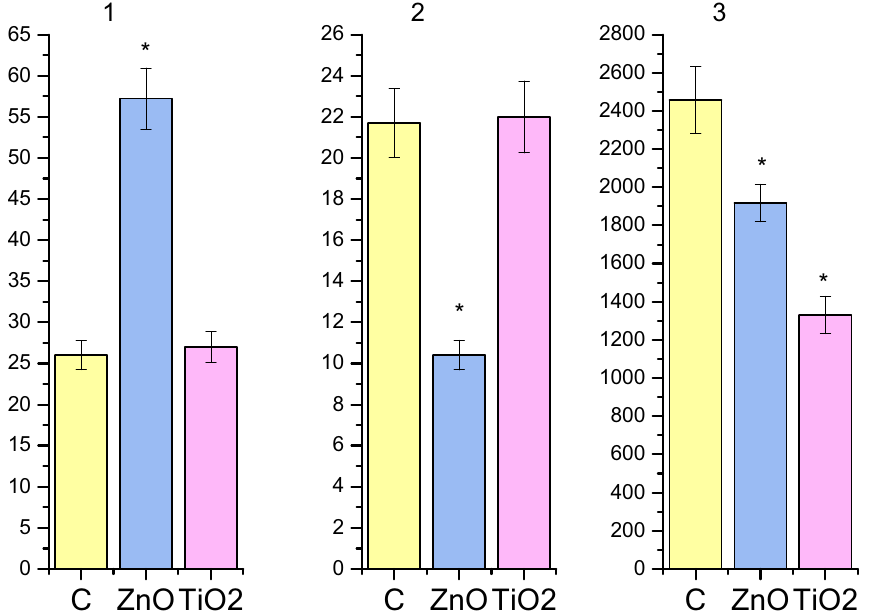
Figure 5. Histograms of the kinetic parameters for the spontaneous contractile activity of the circular SMs of the caecum of rats burdened with ZnO and TiO 2 ANs for 6 months: C—control; ( 1 ) the frequency of contractions of preparations per 10 min.; ( 2 ) an averaged value of the duration of the contraction–relaxation cycle; ( 3 ) AU index of contractions; * p < 0.05 indicates reliability of changes as compared with the